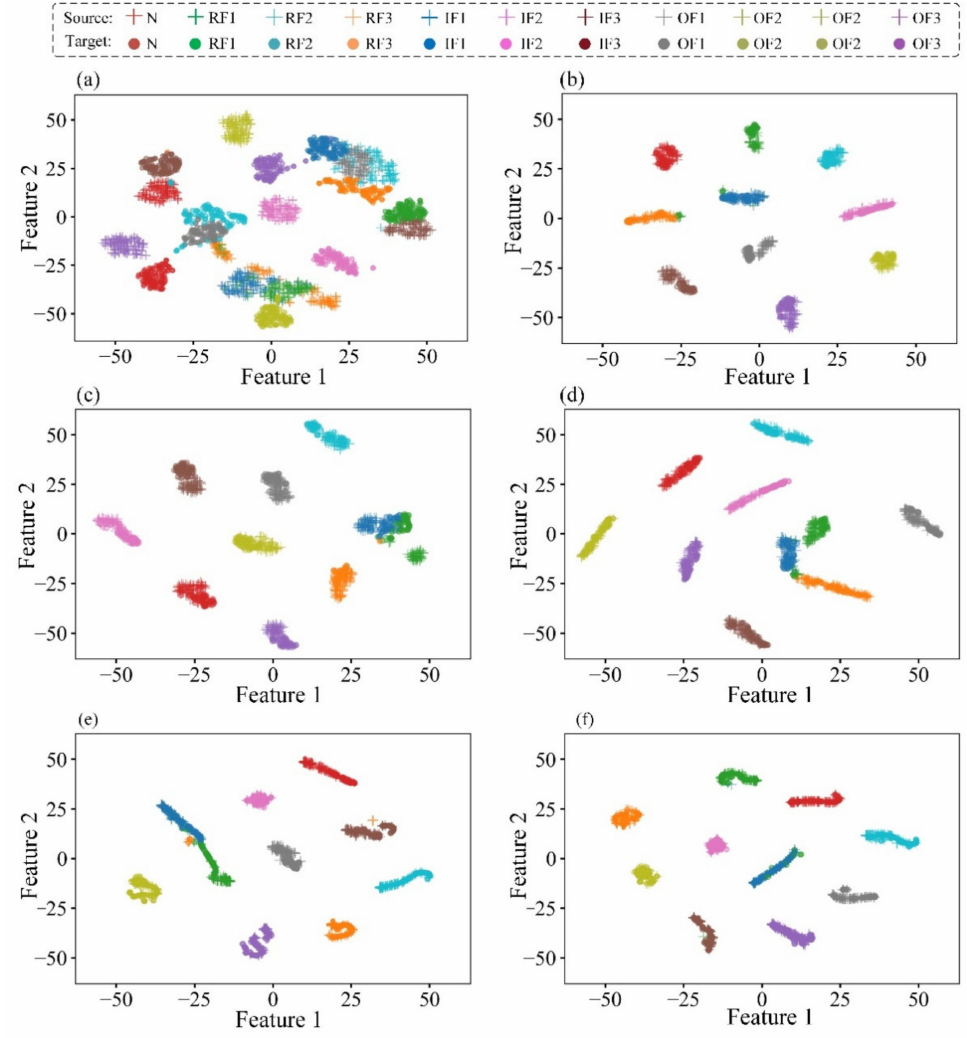
Figure 5. T-SNE feature visualization results of A → B on six methods: ( a ) WEF-SVM, ( b ) ADDA, ( c ) DDC, ( d ) DANN, ( e ) TADA and ( f ) the proposed